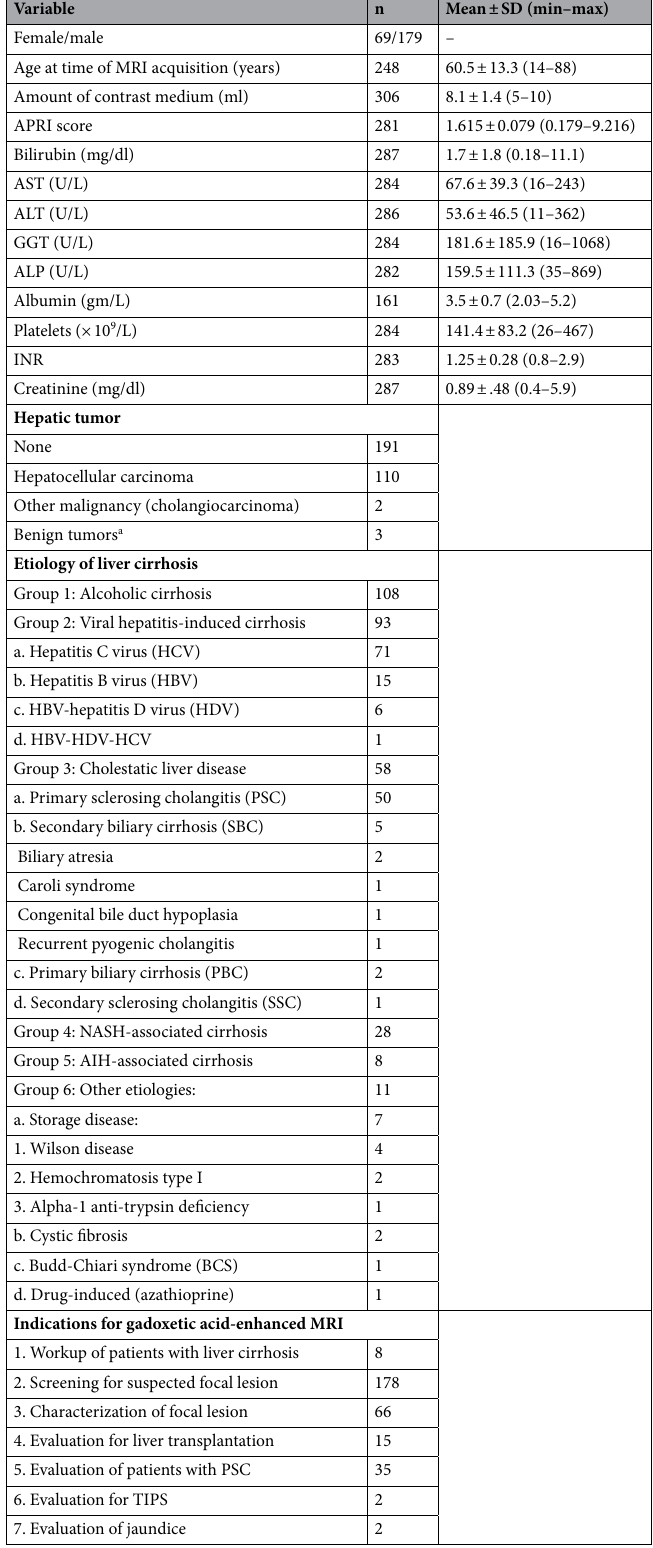
Table 1. Summary of patient demographics. APRI score AST-to-platelet ratio index, AST aspartate aminotransferase, ALT alanine aminotransferase, GGT gamma-glutamyl transferase, ALP alkaline